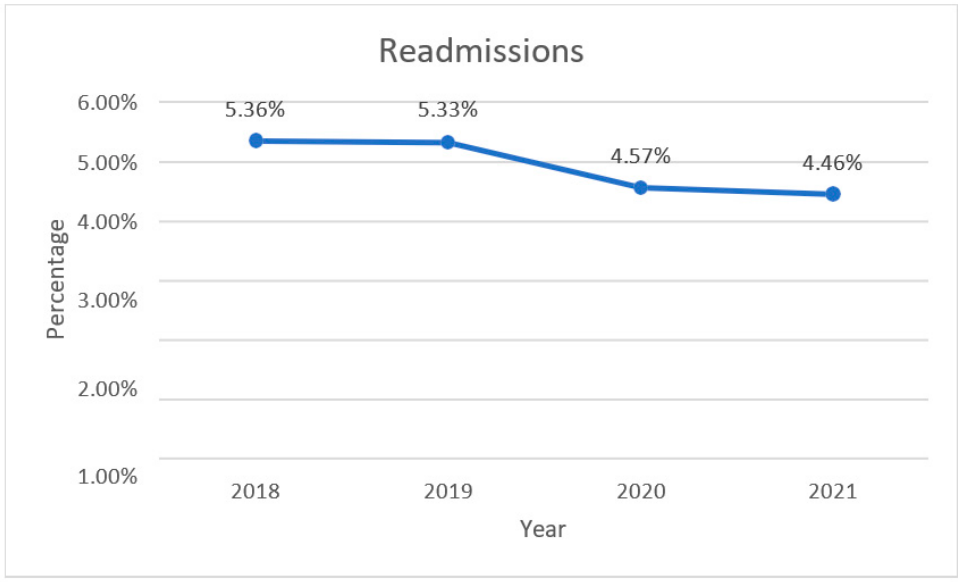
Figure 1. Trend of readmissions in AOUP 2018–2021.